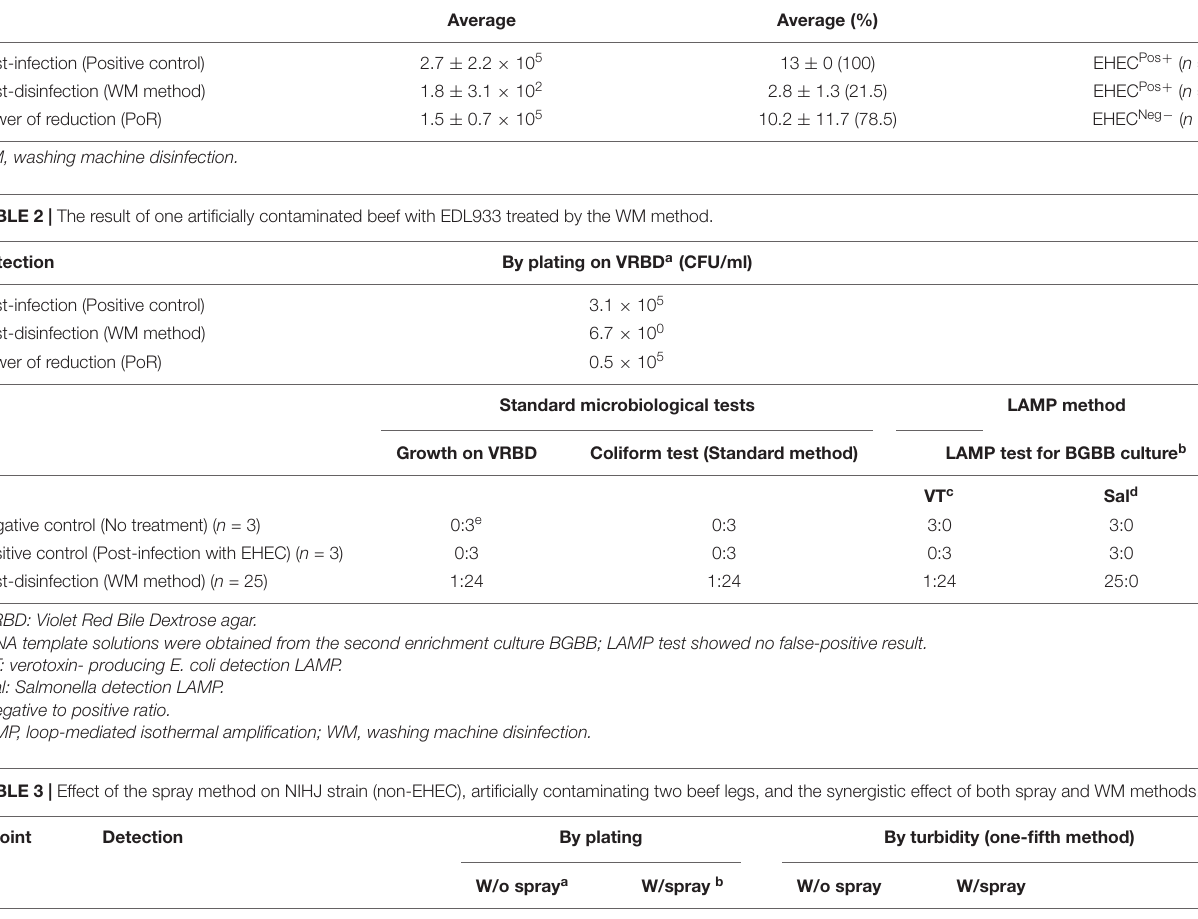
Post-infection (Positive control)